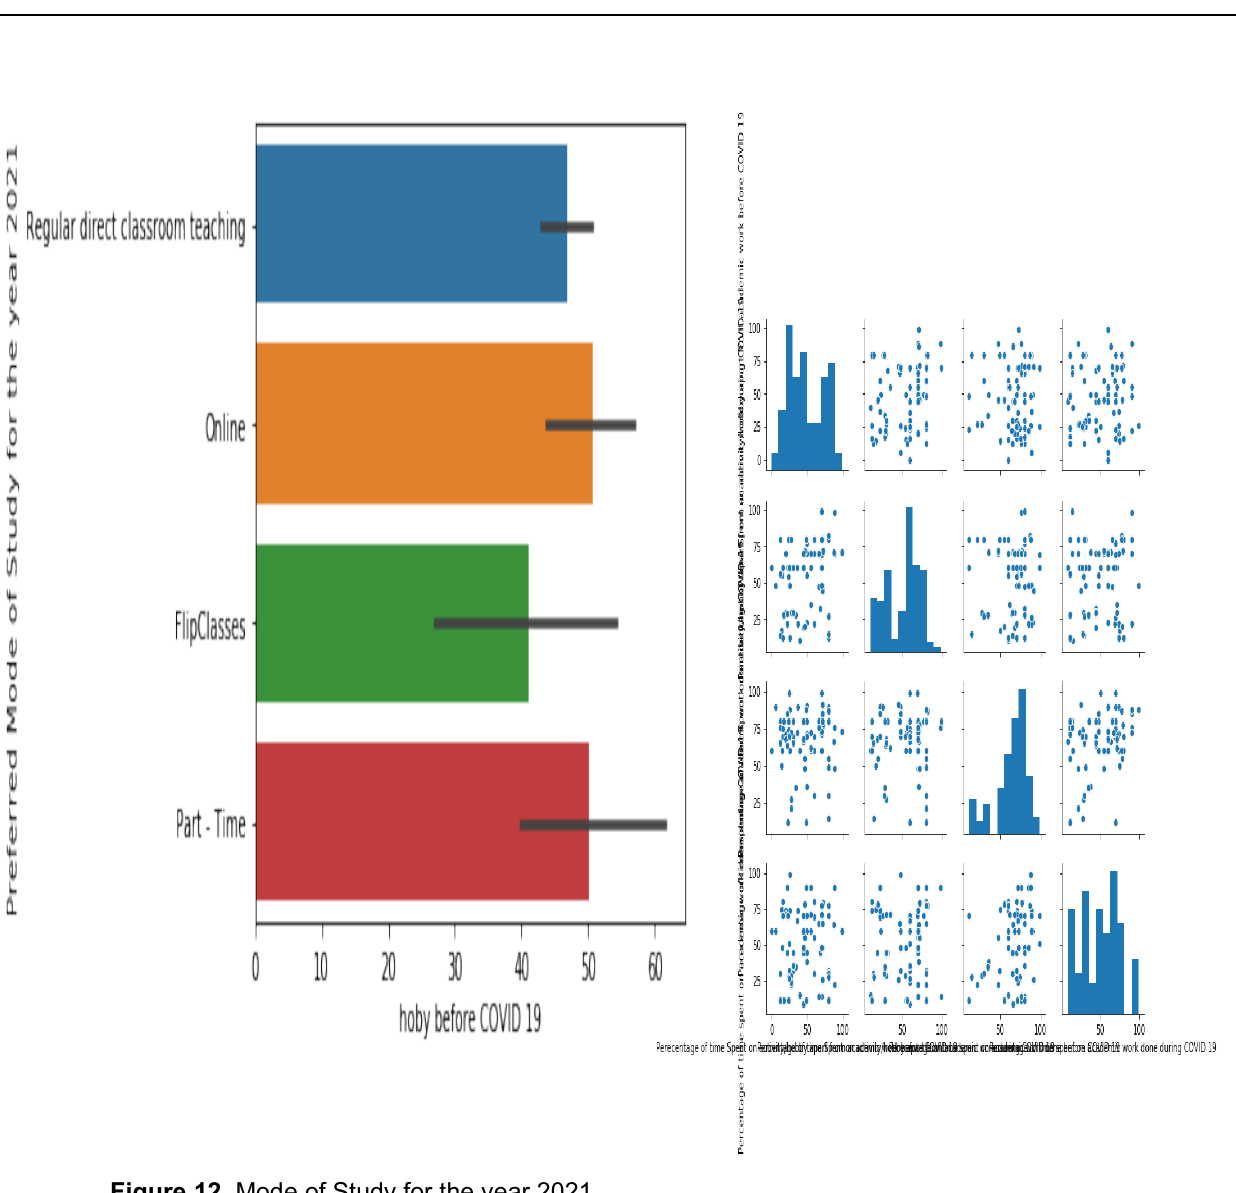
Figure 13. Layout for Teaching learning process